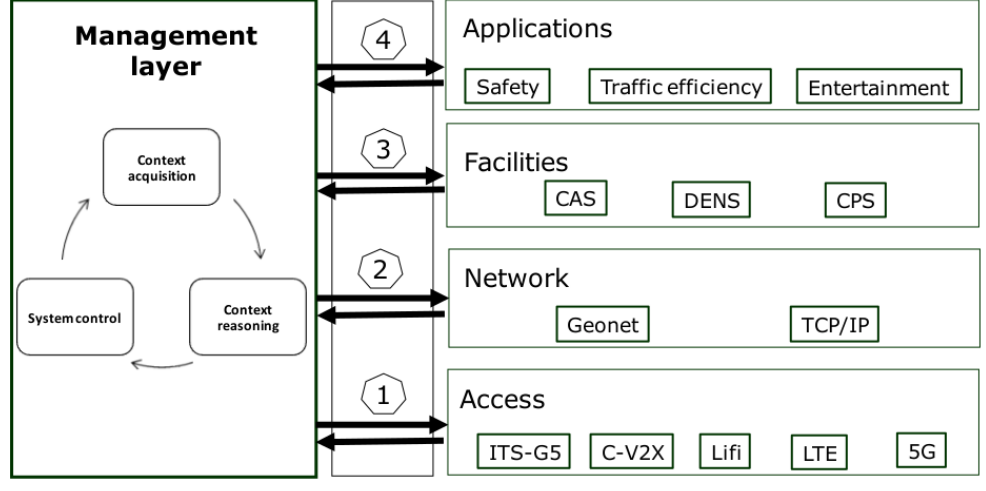
Figure 1. Context-aware communication